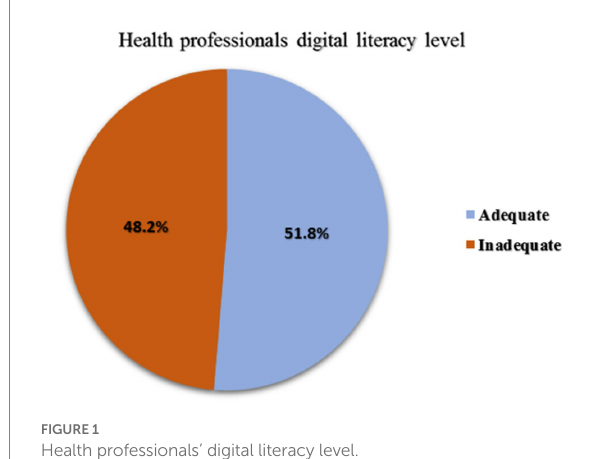
FIGURE 1 Health professionals’ digital literacy level.